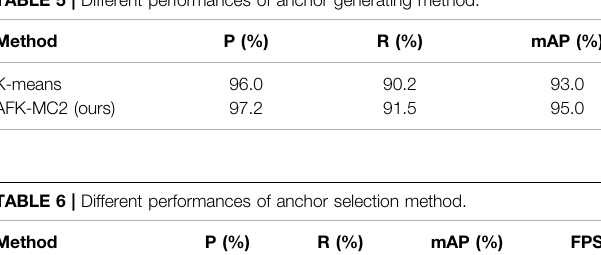
TABLE 5 | Different performances of anchor generating method.